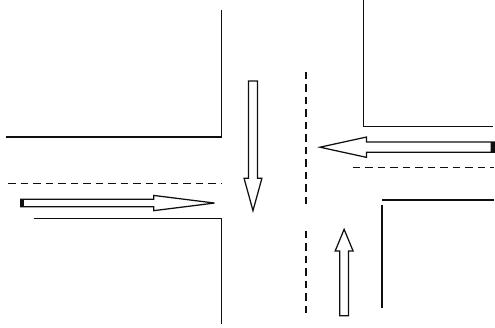
Figure 5: An intersection in a traffic network with four